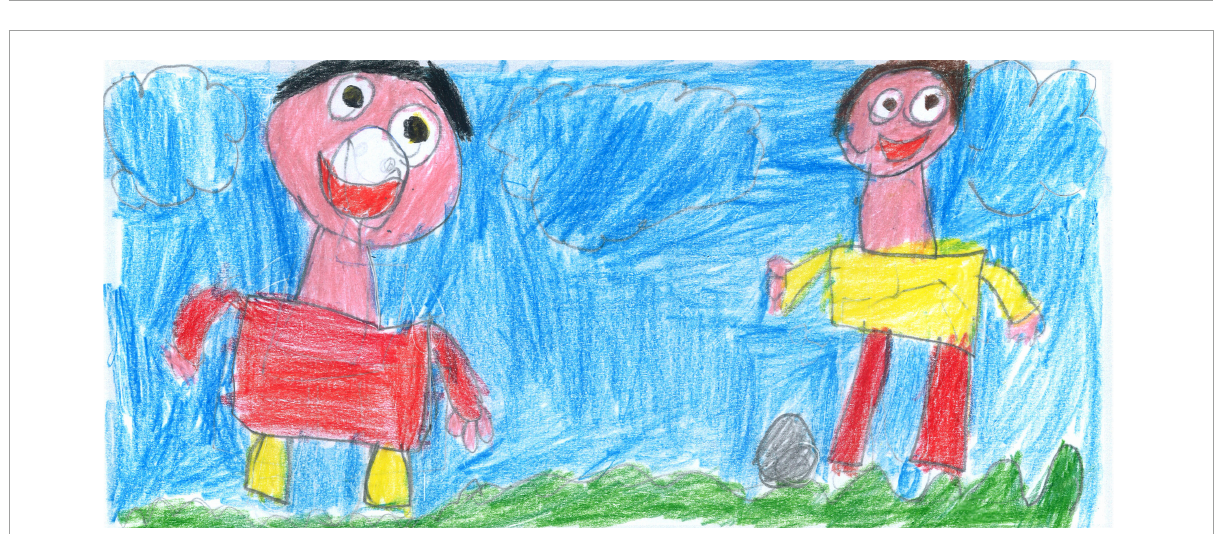
FIGURE6 When a play buddy is present, the illustrations are richer in color and details. According to the PAIR system, this picture also has a high cohesion ranking because the children stand on a common area, share the same activity, and are moving toward each other (PS, Male, 8